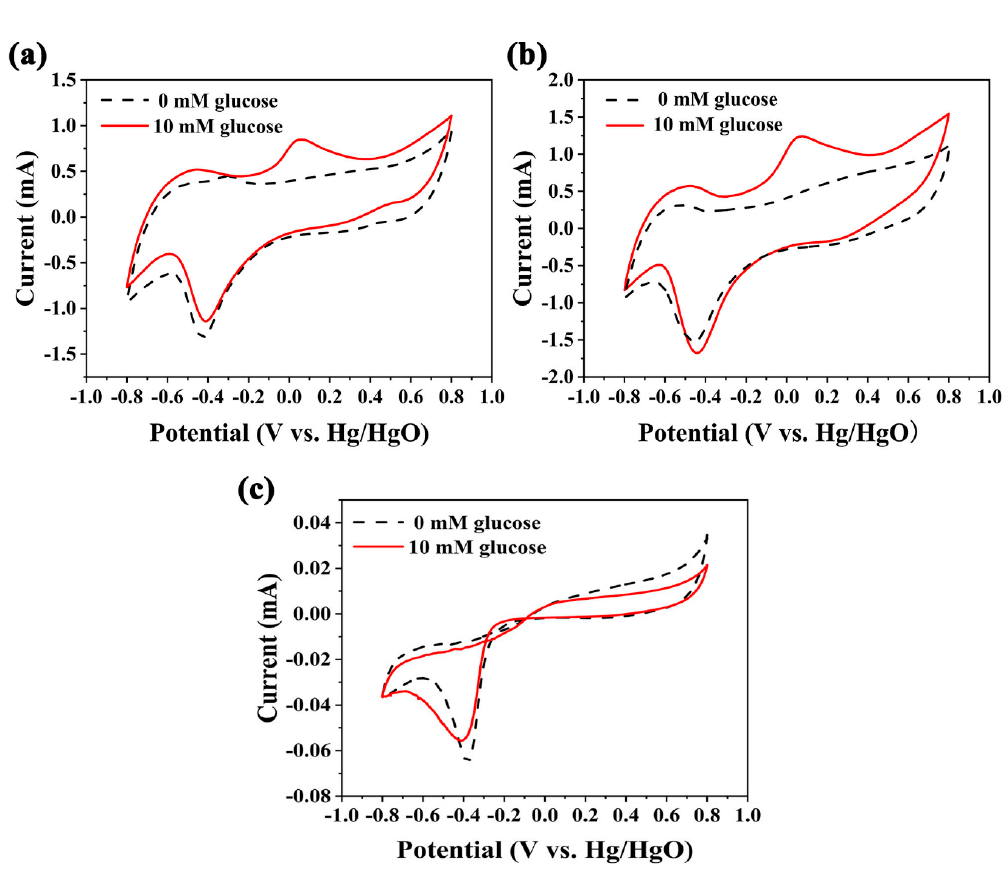
Figure 4. Cyclic voltammetries (CVs) at of ( a ) Pd / C, ( b ) Pd / C 3 N 4 -C, and ( c ) Pd / C 3 N 4 , 0.1 M NaOH solution, and 50 mV s − 1 .